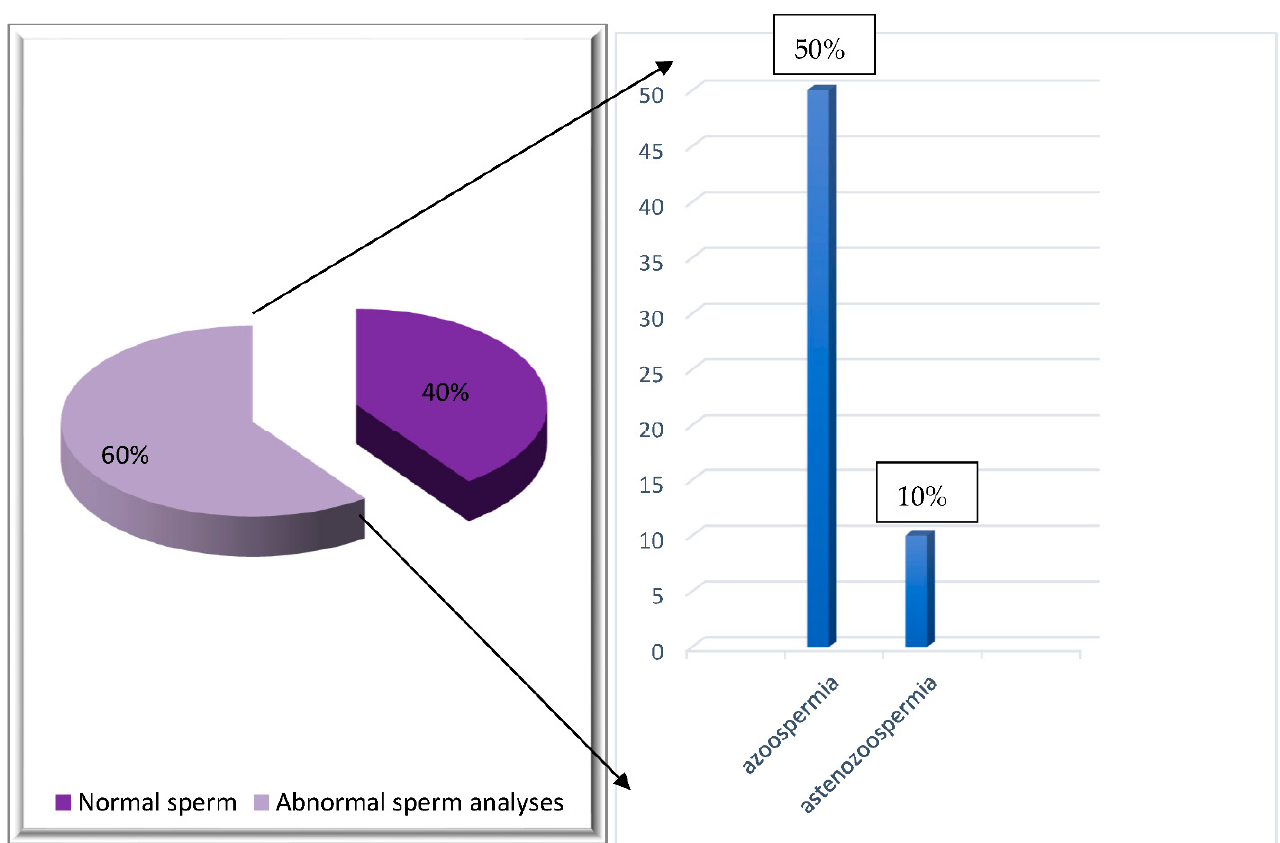
Figure 3. Distribution of HD patients according to spermogram findings following BEACOPP